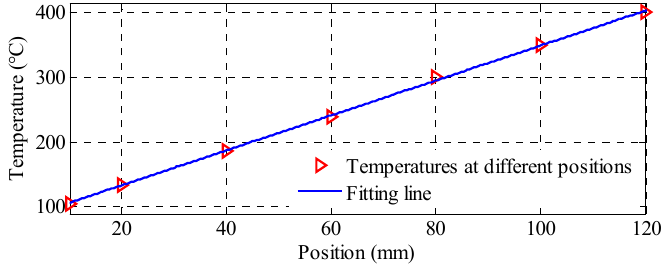
Figure 5. Temperatures at different positions.